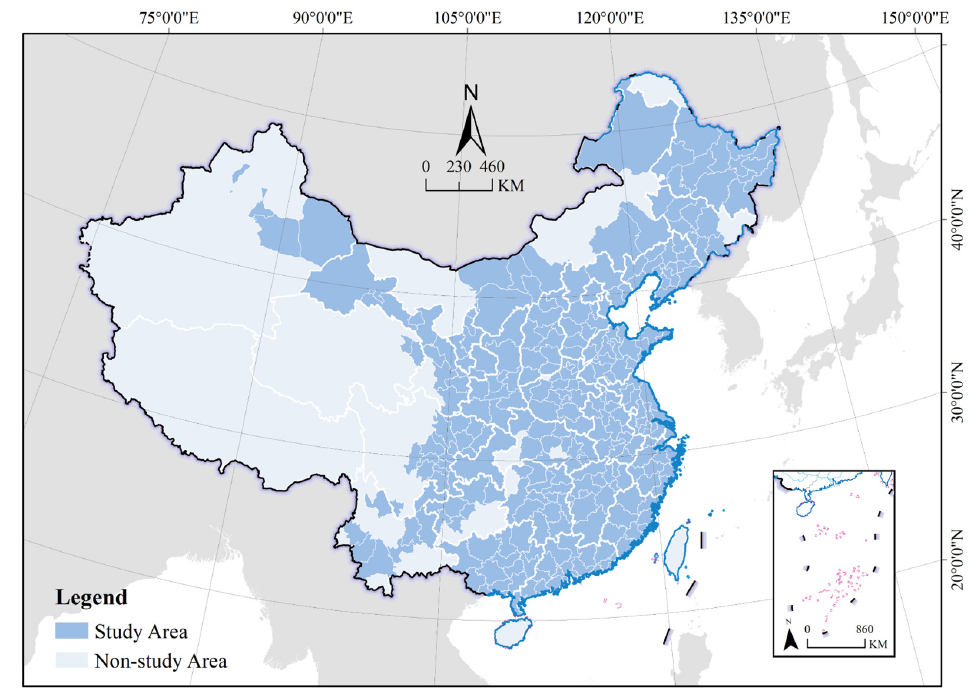
Figure 1. Study Area. The approval number of the national boundary of China is GS (2020) 4628,